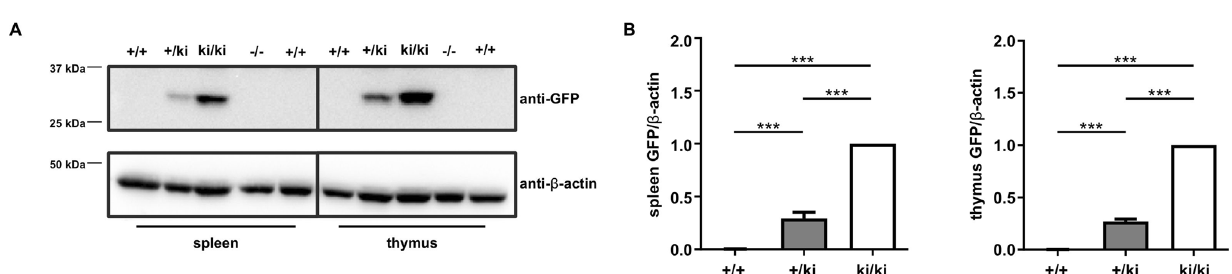
Figure 2. GFP expression in Gnai3 -iresGFP reporter mice. ( A ) Representative immunoblots of GFP expression in spleen and thymus derived from wild-type, heterozygous and homozygous Gnai3 -iresGFP mice. 20 µg protein lysate were loaded in each lane. Equal loading was confirmed by β-actin detection. ( B ) Statistical analysis of GFP expression in spleen (left) and thymus (right) of Gnai3 -iresGFP mice. The intensities of the GFP bands were normalized to the relative intensity of the loading control β-actin (n = 5 per genotype). Data are represented as mean ± SD and were analyzed using multiple comparison one-way ANOVA followed by post-hoc comparison with Bonferroni’s multiple comparison. Uncropped blots are shown in Supplemental Figure